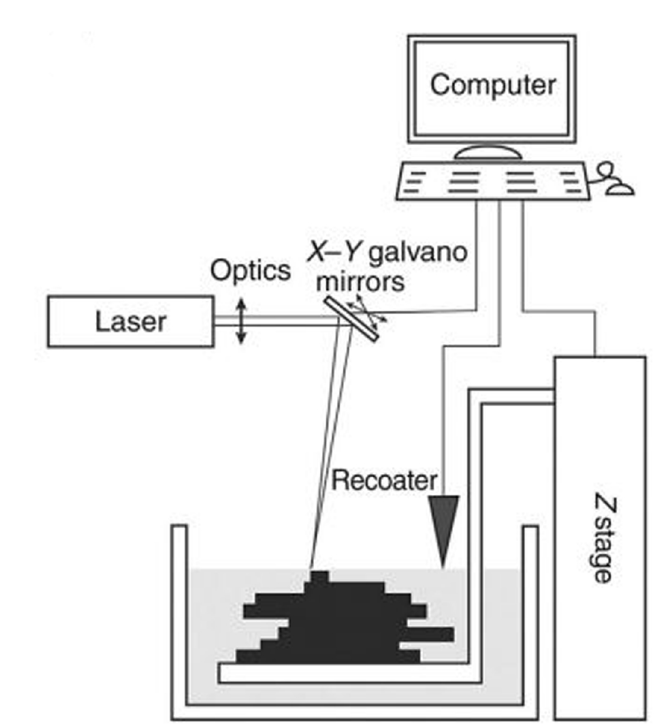
Figure 22. Schematic of microstereolithography technique. Reprinted with permission from Ref. [145]. Copyright 2020,